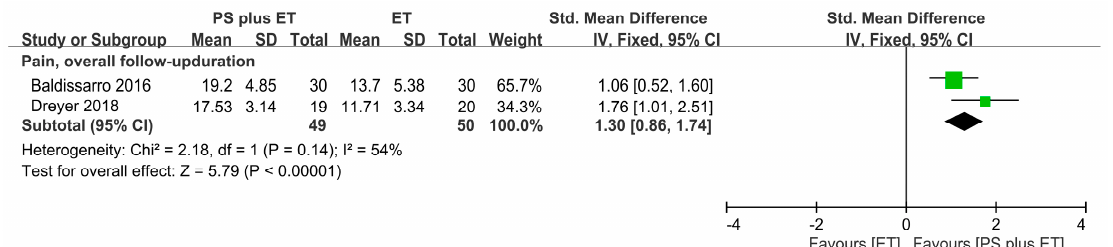
Figure 3. Forest plot summarizing the effects of postoperative protein supplementation (PS) plus exercise training (ET) on changes in the pain score over the overall follow-up period. The square represents the point estimate of the intervention effect for each trial. The horizontal line links the lower and upper limits of the 95% CI for the given effect. The area of the squares indicates the relative weight of the trials in the meta-analysis. Trial results plotted on the right-hand side of the vertical axis indicate effects in favor of protein supplementation. The combined effects are plotted using black diamonds. 95% CI, 95% confidence interval; Std, standard; IV, inverse variance.